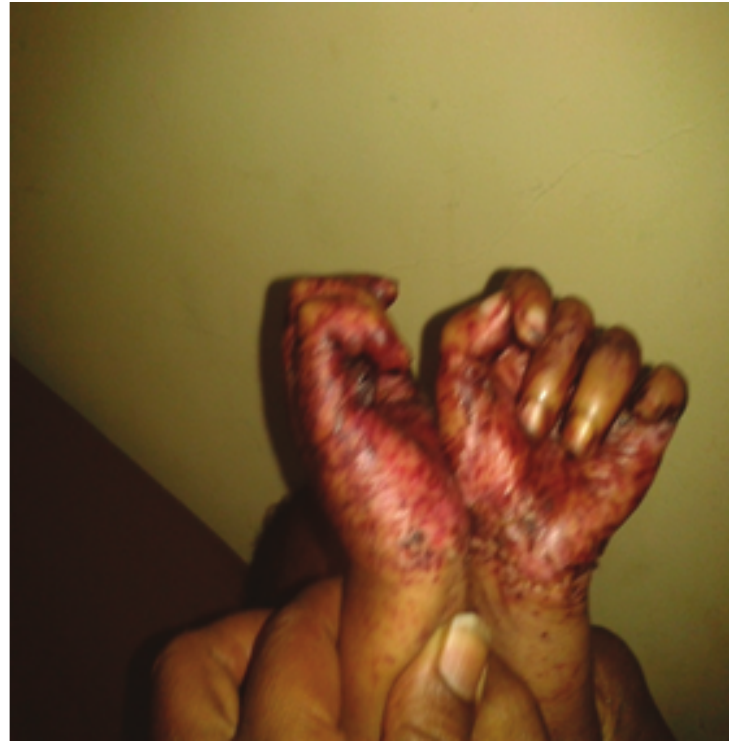
Figure 3: Hands purpura and